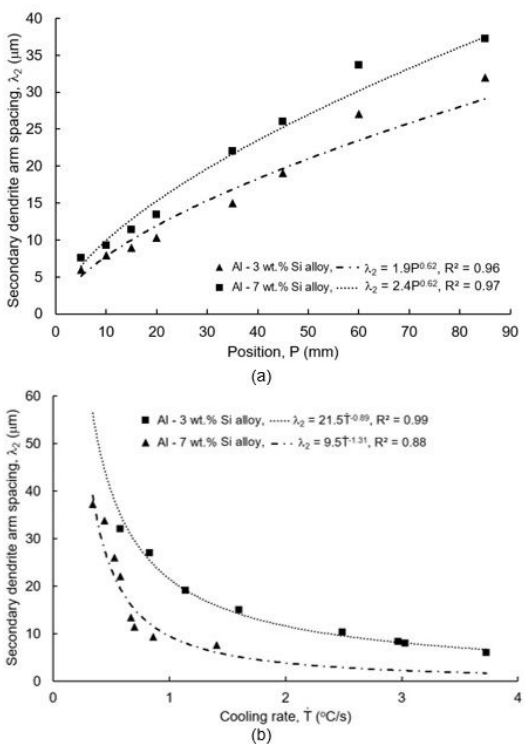
Figure 11. Secondary dendrite arm spacing (λ ( P ) along the castings, and b) cooling rate ( T  ).